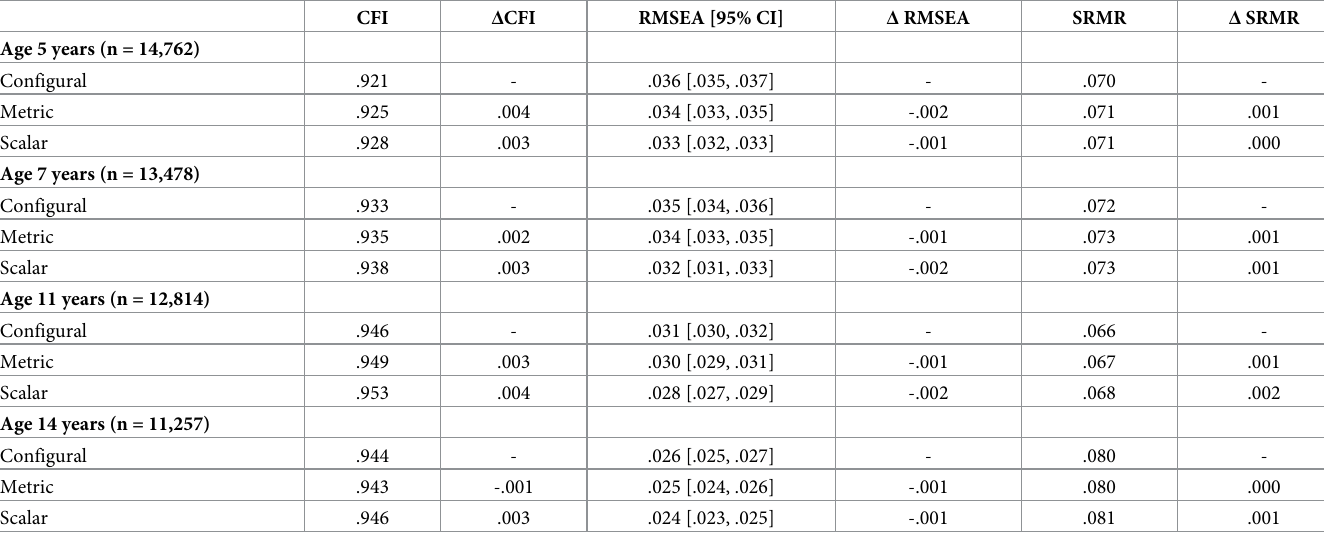
Table 5. Ethnicity measurement invariance